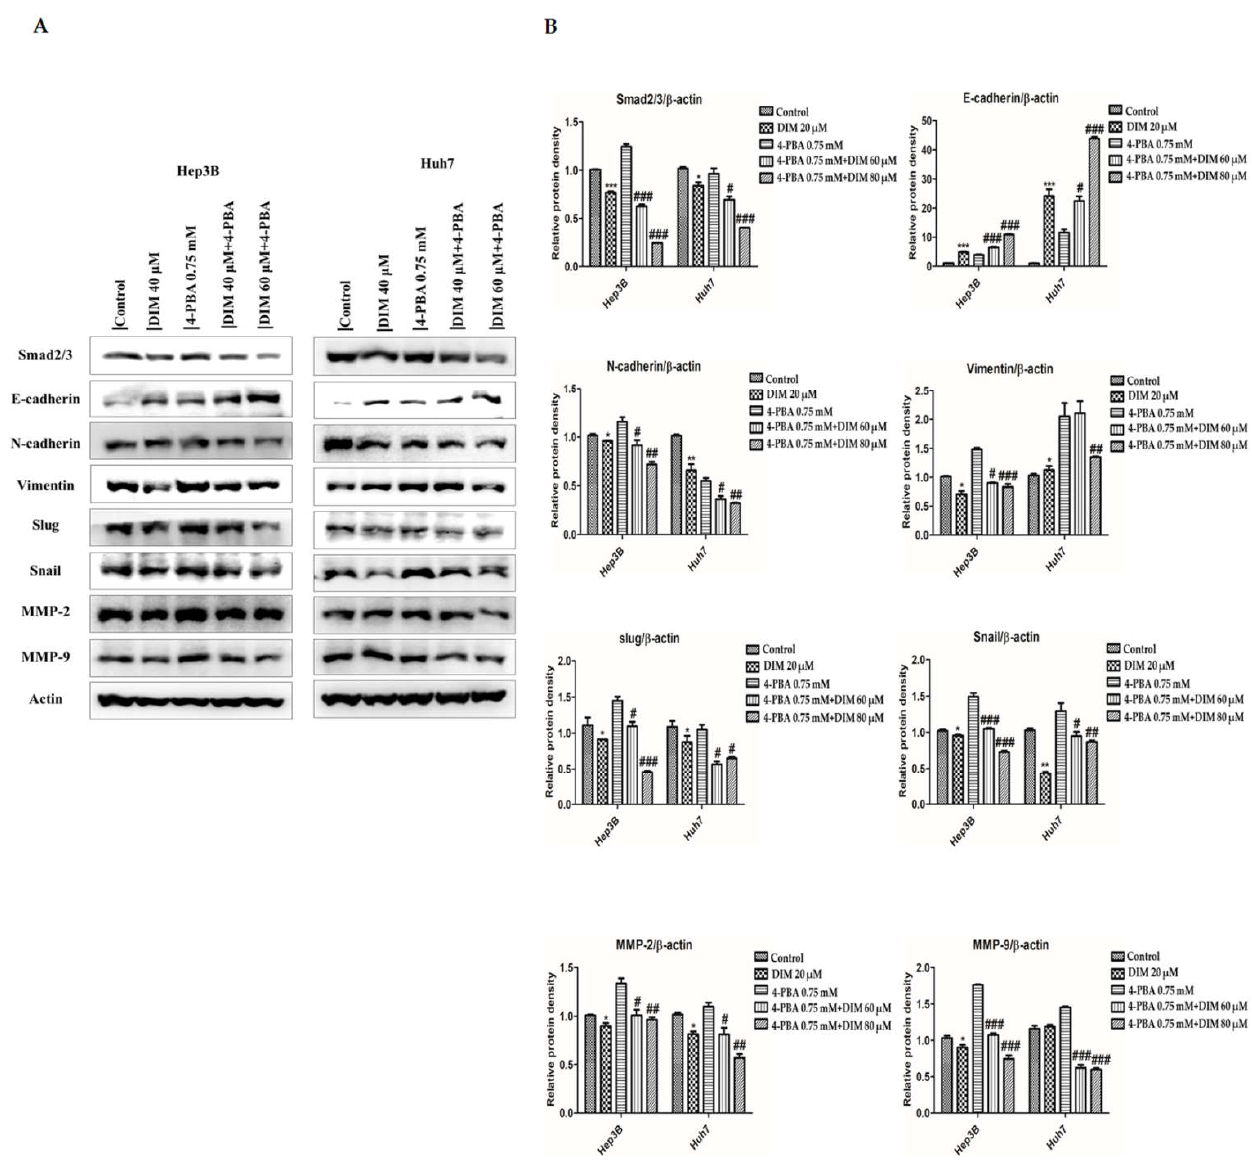
Figure 8. DIM modulates EMT regulatory proteins levels in HCC cell lines. ( A ) Western blot analysis to determine the effect of DIM on the expression of ER-stress regulated EMT proteins levels in Hep3B and Huh7 cells after 24 h DIM treatment. ( B ) Quantification of relative protein expression normalized to β-actin. Provided data represents the mean ± SE of three independent experiments. *, p < 0.05; and ***, p < 0.001 denote significant variation compared to the control group and # , p < 0.05; ## , p < 0.01; and ### , p < 0.001 denote significant variation compared to the 4-PBA treated group.